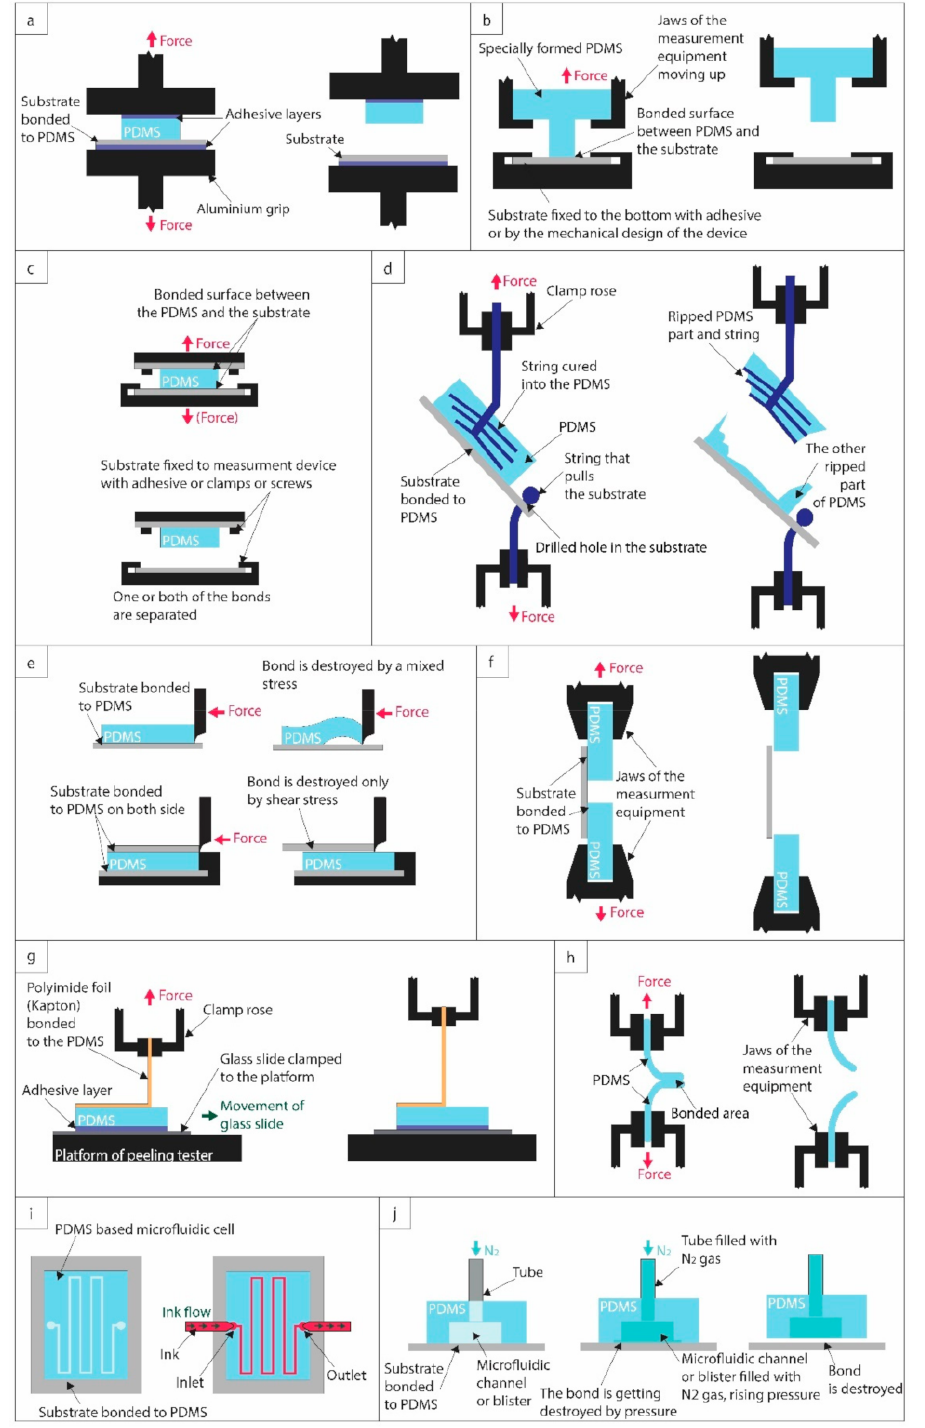
Figure 1. Illustrations of different bond-strength testing methods. ( a ) Tensile strength measurement with adhesive. ( b ) Cylinder-based tensile strength measurement with a specially designed PDMS piece. ( c ) Double-substrate bonding-based tensile strength measurement. ( d ) String-based tensile strength measurement. ( e ) Pushing-based shear strength measurement. ( f ) Pulling-based shear strength measurement. ( g ) Peeling test. ( h ) T-peeling test. ( i ) Leakage test. ( j ) Burst